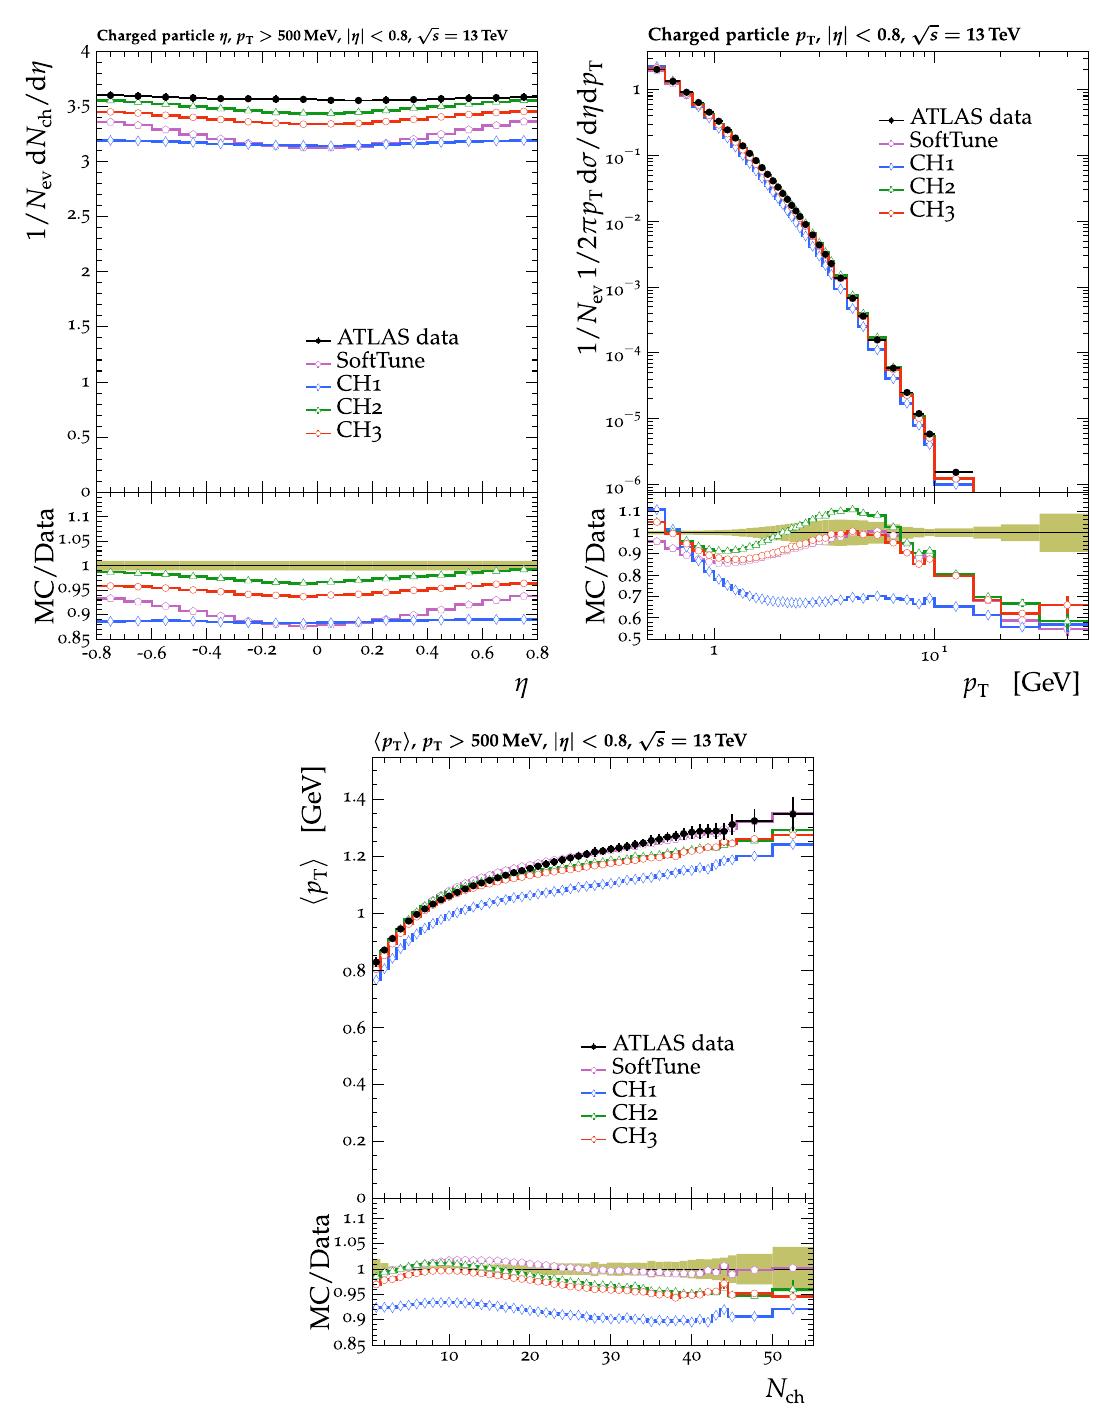
Fig. 25 Normalized plots [48] for the pseudorapidity of charged par- ticles (upper left), charged-particle p T distribution (upper left), and the mean charged-particle p T distribution as a function of the charged- particle multiplicity (lower), all for | η | < 0 . 8. ATLAS MB data are